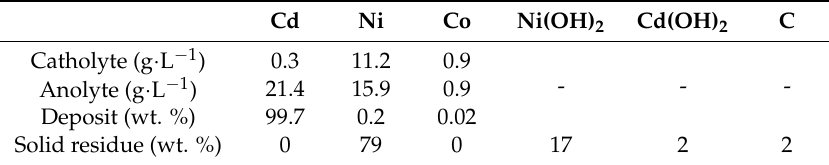
Table 3. Composition of electrolytes and solids after 5 hr treatment at 350 A · m − 2